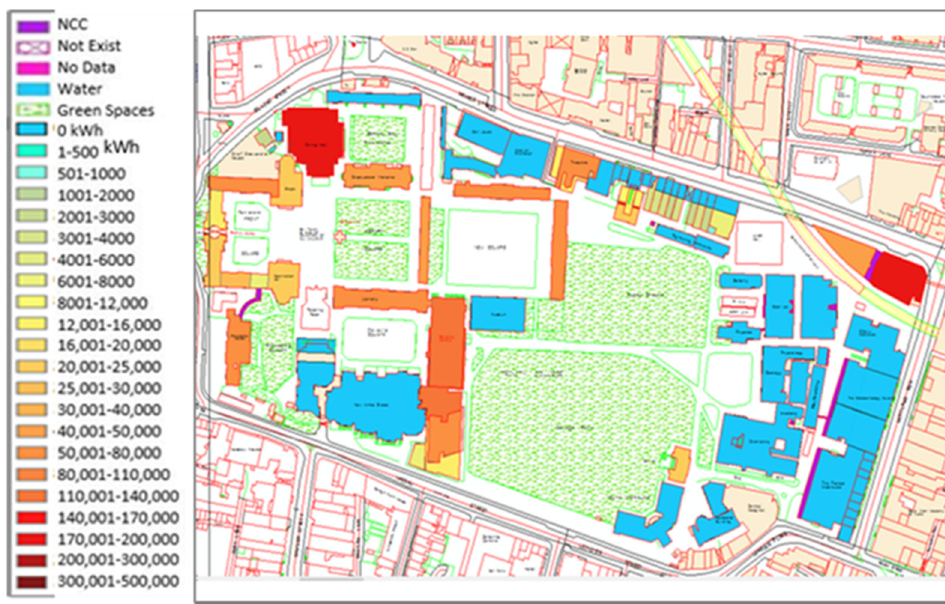
Figure 5. The heat demand map of July.